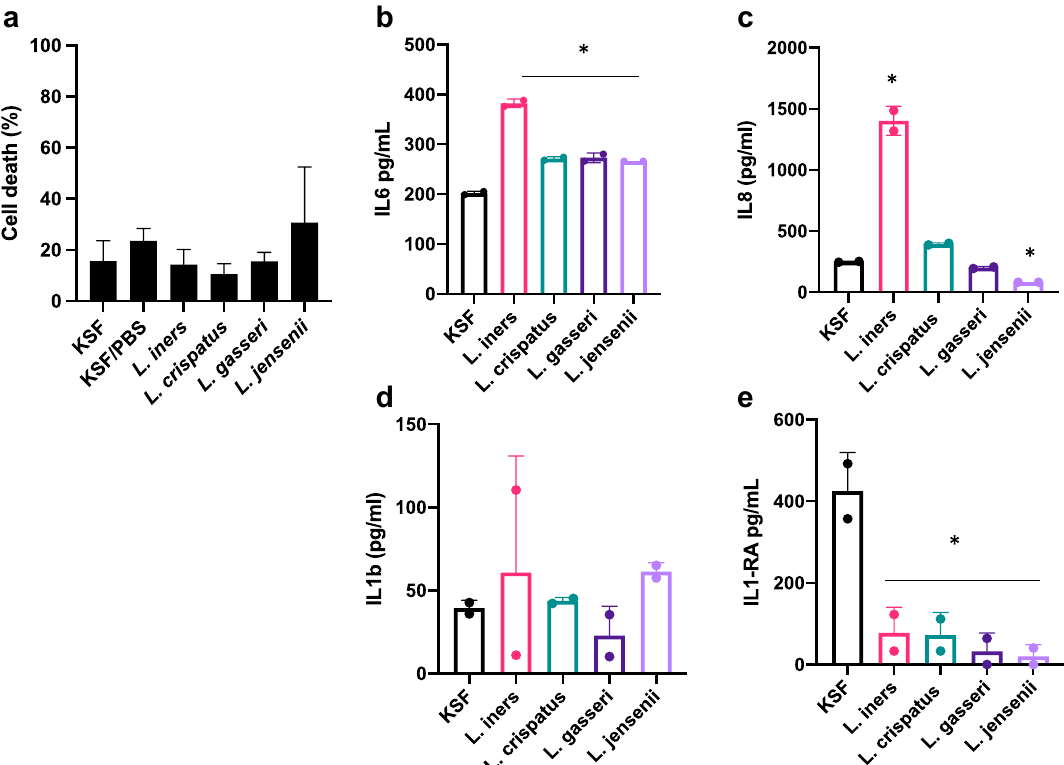
Figure 3. Impact of bacteria on vaginal epithelial cells. An immortalized vaginal epithelial cell line was cultured with a suspension of Lactobacillus iners, L. crispatus, L. gasseri or L. jensenii in cell culture medium (OD 0.1) for 24 h. Cell death ( a ) was measured using an LDH assay and IL6 ( b ), IL8 ( c ), IL1β ( d ) and IL1-RA ( e ) were measured in supernatant by ELISA. Results are presented as mean ± SD from at least two separate experiments.